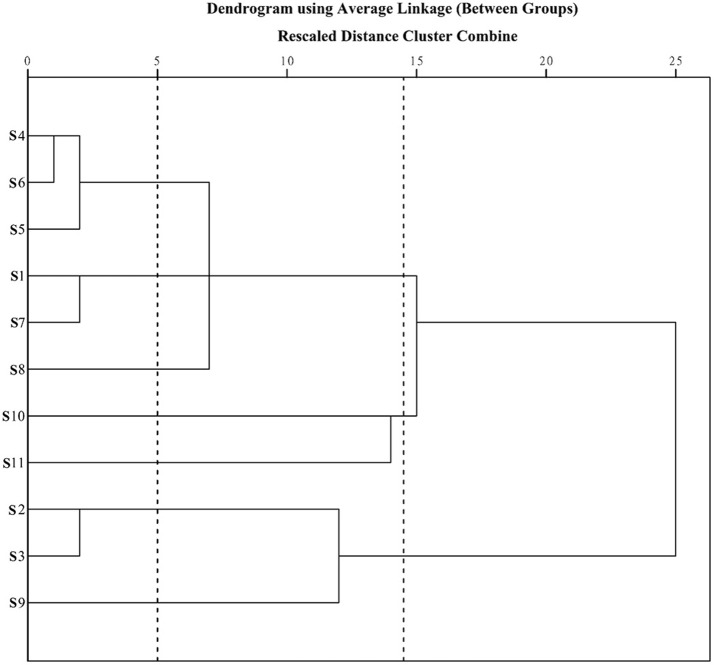
Dendrograms of hierarchical cluster analysis (HCA) for samples of J. rigida.